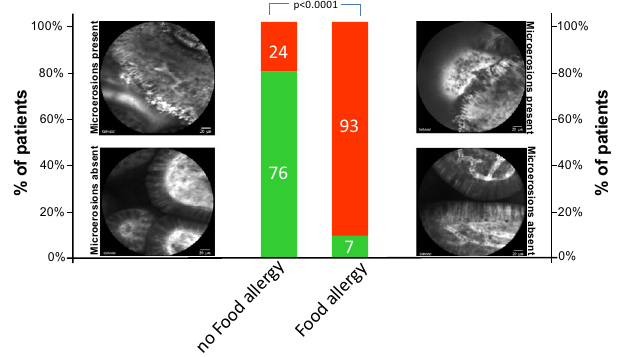
Figure 3. Microerosions in the terminal ileum in patients with and without Food Allergy. Microerosions, defined as an exposure of the lamina propria to the lumen with multiple cells being shed per site, were found in 25 out of 27 patients (92.6%) with FA. In the non-FA group, 8 out of 33 patients exhibited microerosions in the terminal ileum (24.2%). Differences in the prevalence of microerosions between patients with and without FA were statistically significant ( p < 0.0001). Red segment of each bar: percentage of patients with microerosions, green segment of each bar: percentage of patients without microerosions.